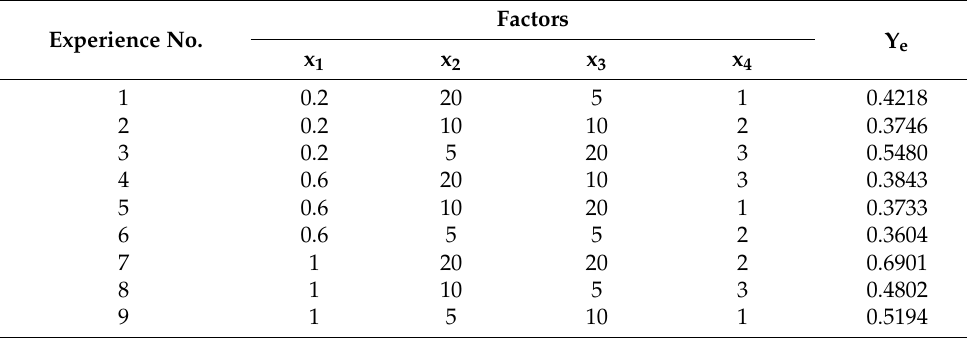
Table 5. Factor planning matrix at three